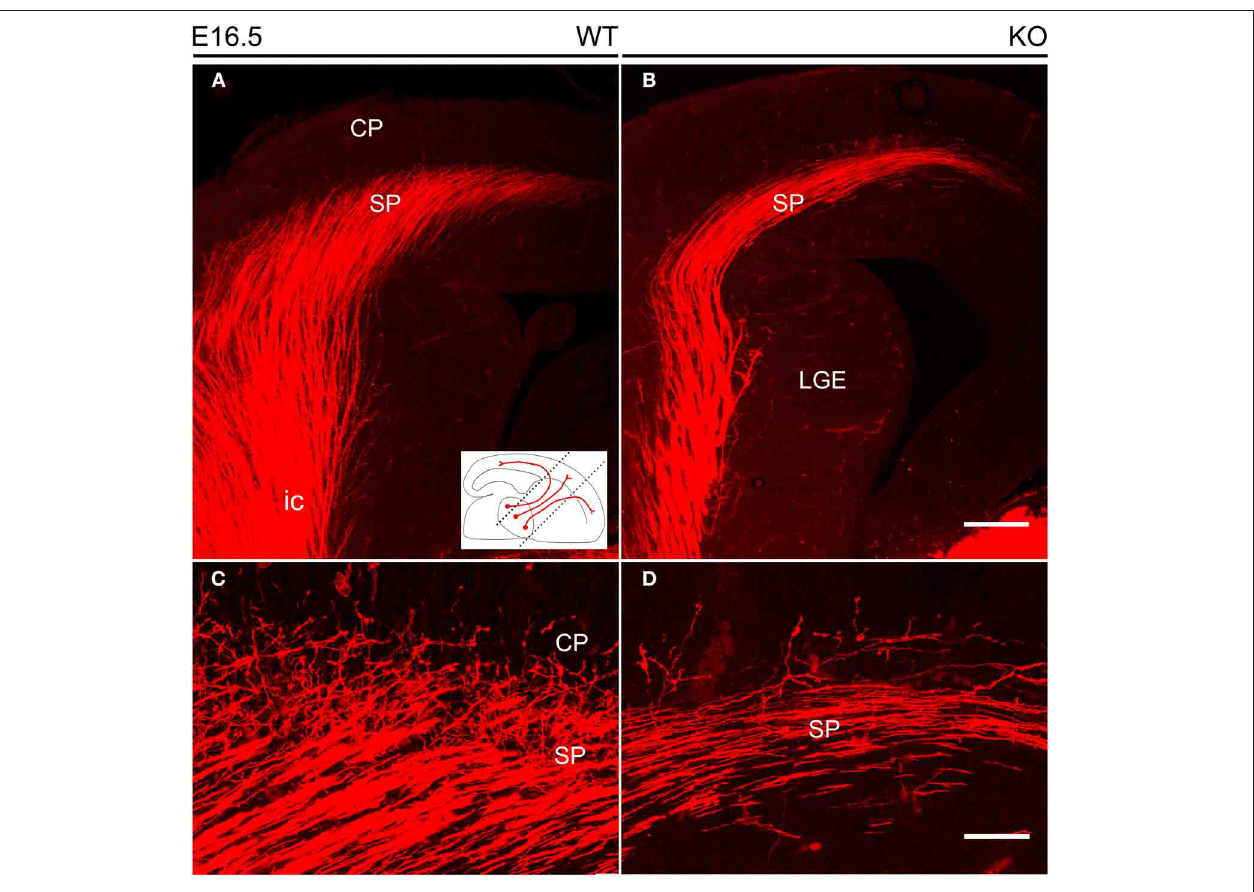
TC axons started their entry into the cortical plate, but these axonal arborizations were visibly more profuse in wild type (C) than in NCAM null mice (D) . Images are maximum projections of confocal optical sections, covering total thicknesses of 29 μ m (A,B) or 11 μ m (C,D) . CP, cortical plate; ic, internal capsule; LGE, lateral ganglionic eminence; SP, subplate. Bars: 200 μ m (A,B) ; 50 μ m (C,D)